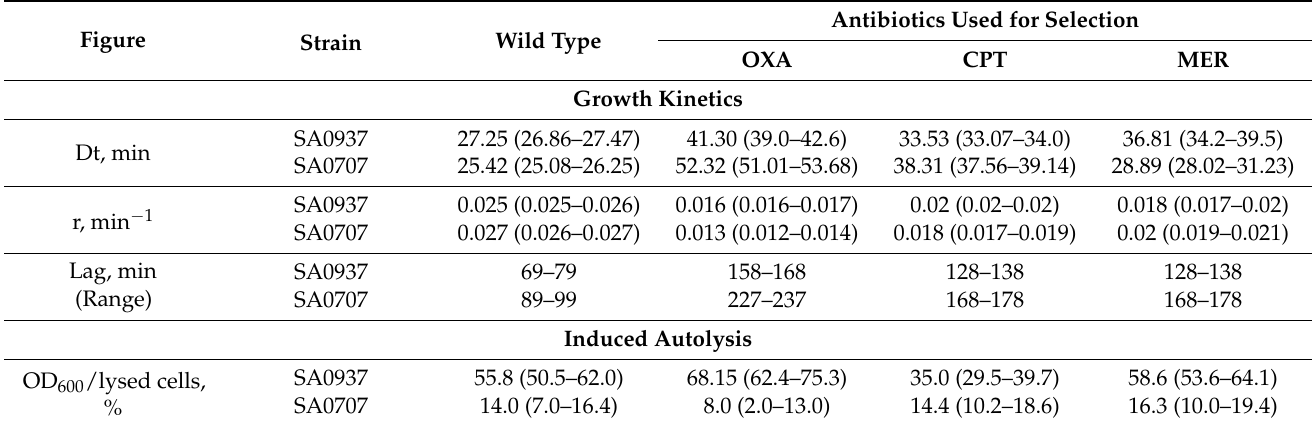
Table 2. Phenotypic features of parental and isogenic derivatives. Antibiotics Used for Selection Figure Strain Wild Type OXA CPT MER Growth